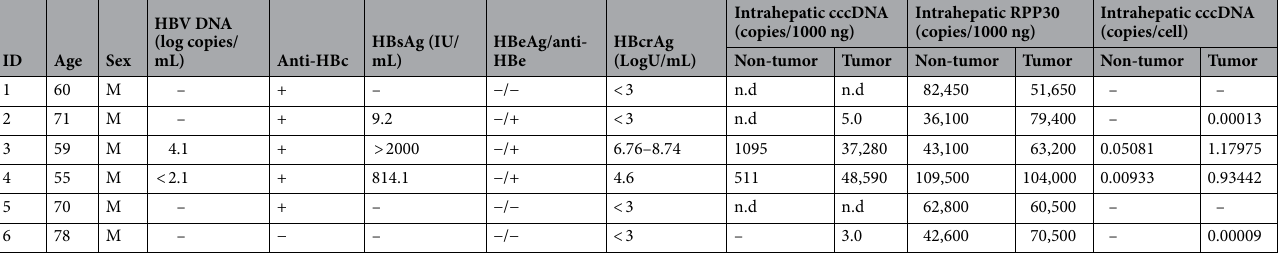
Table 1. Specific detection of HBV-DNA, cccDNA, HBsAg and HBcrAg in the sera and livers of 6 selected